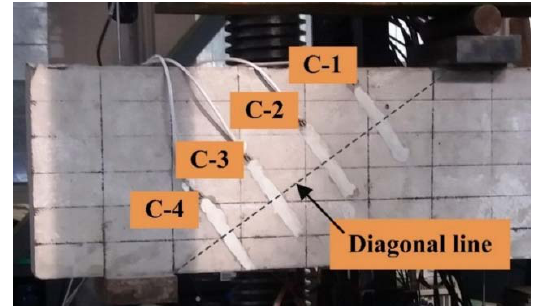
Figure 4. Positions of concrete strain gauges along the diagonal section.